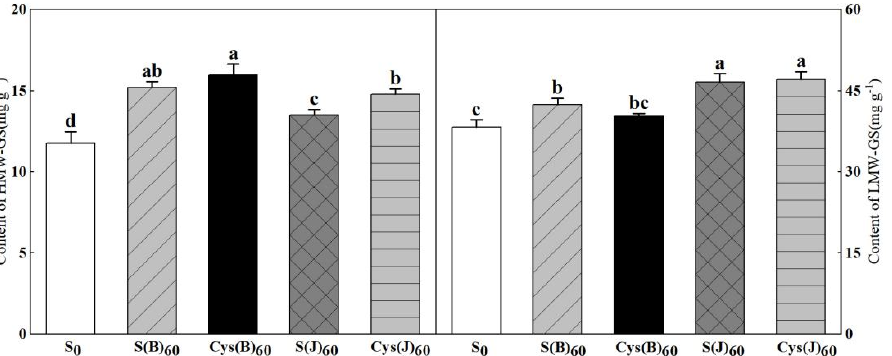
Figure 2. Effects of cysteine and inorganic sulfur at different stages on contents of total HMW-GS and LMW-GS in flour. Different small letters in the same column of each treatment are significantly different at a 0.05 probability level.